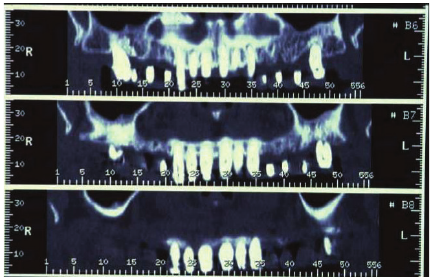
Figure 13: Sling vertical mattress sutures were used to achieve passive flap adaptation to the bone crest.